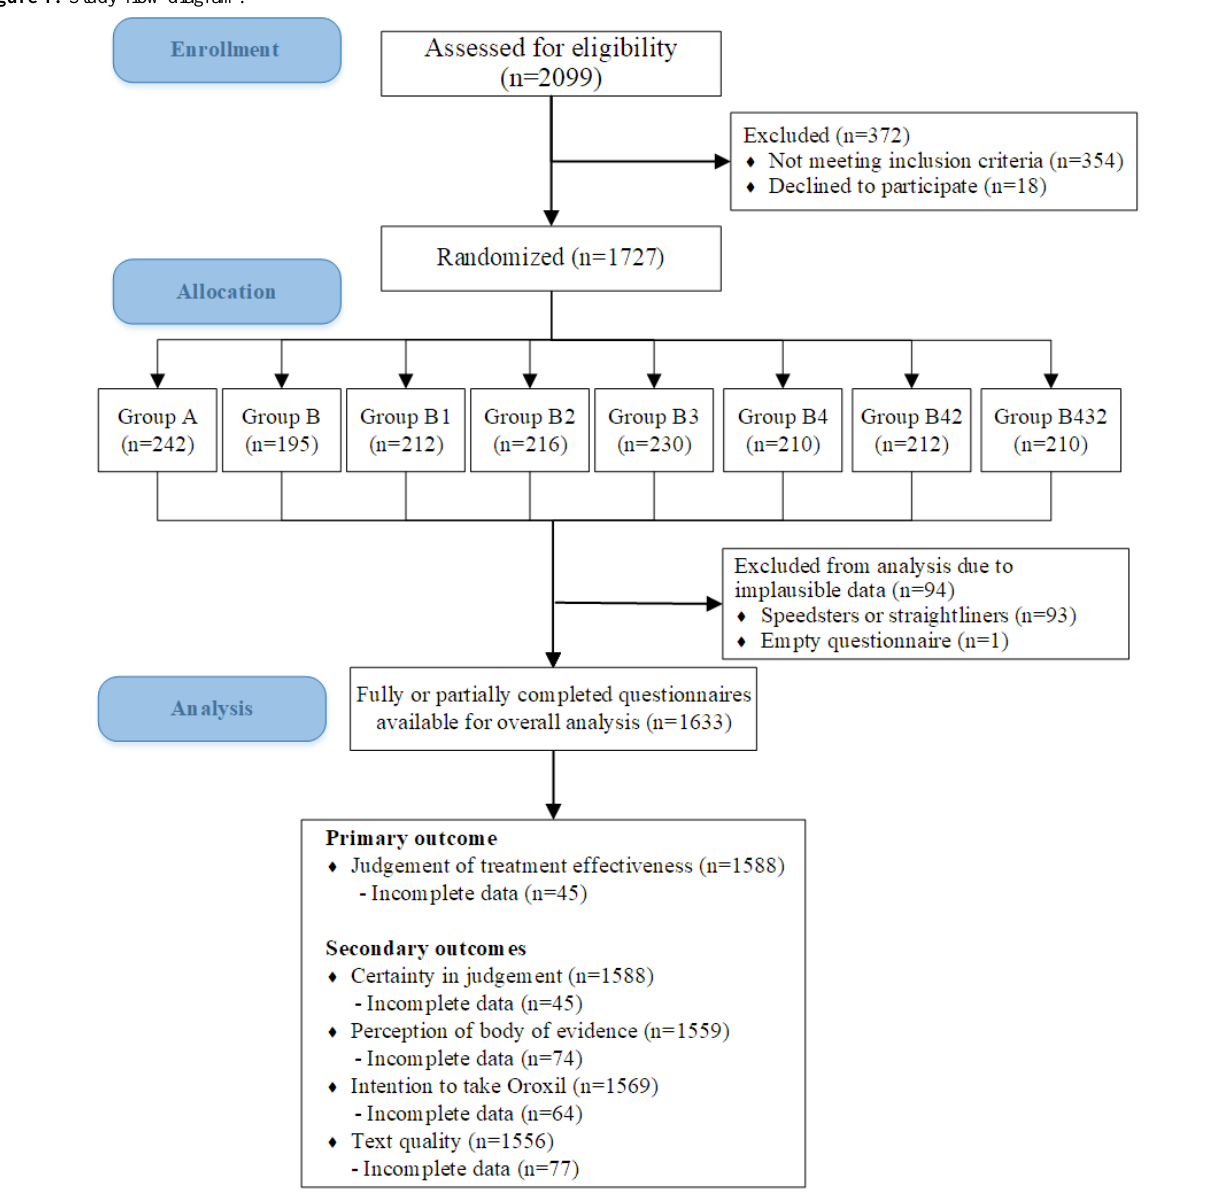
Figure 1. Study flow